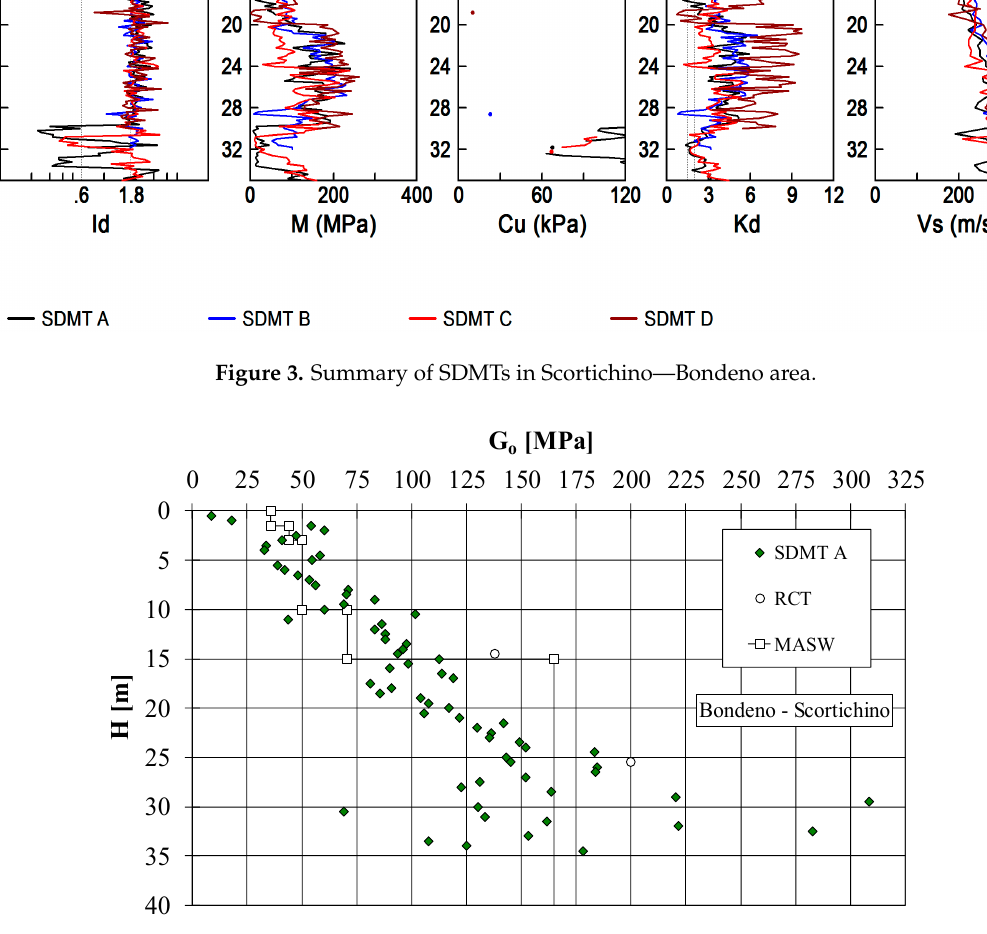
Figure 4. G o from laboratory and in situ tests.